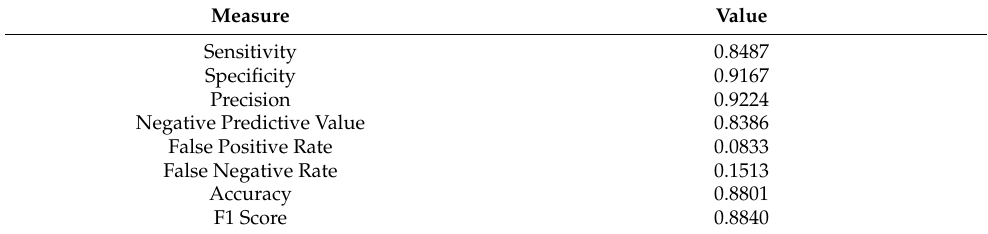
Table 10. GLM Confusion Matrix Measure Values.